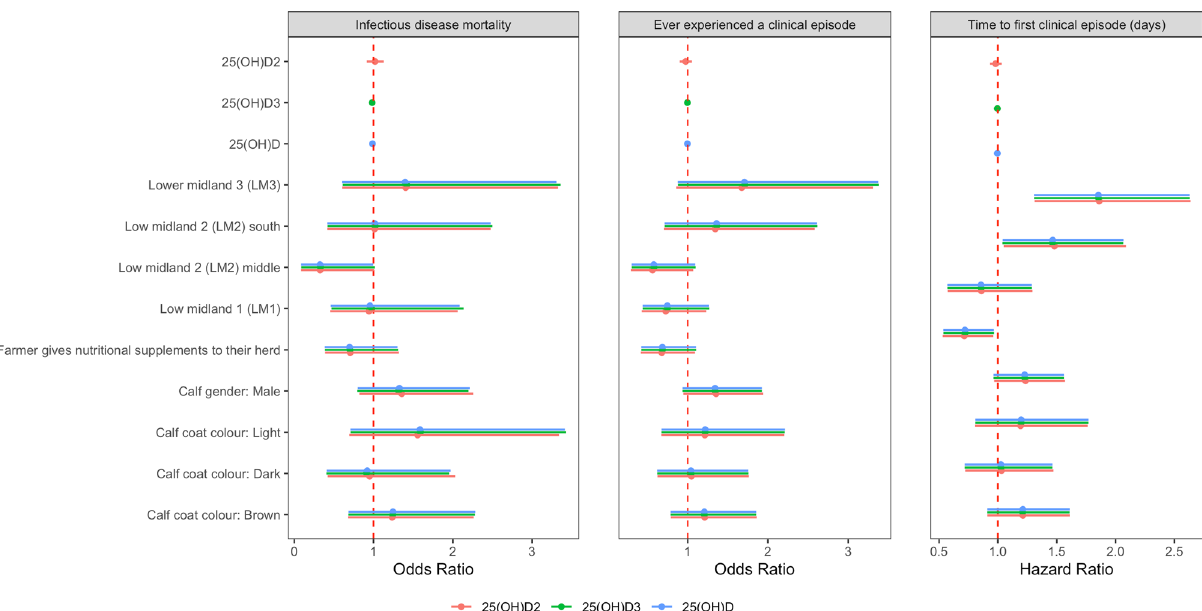
Figure 9. Estimates of effect sizes for the association between infectious disease mortality and morbidity by one year of age and serum 25(OH)D concentration after accounting for calf level factors and vitamin D. Factors are considered important if their confidence intervals do not span one, as indicated by the dotted vertical line.